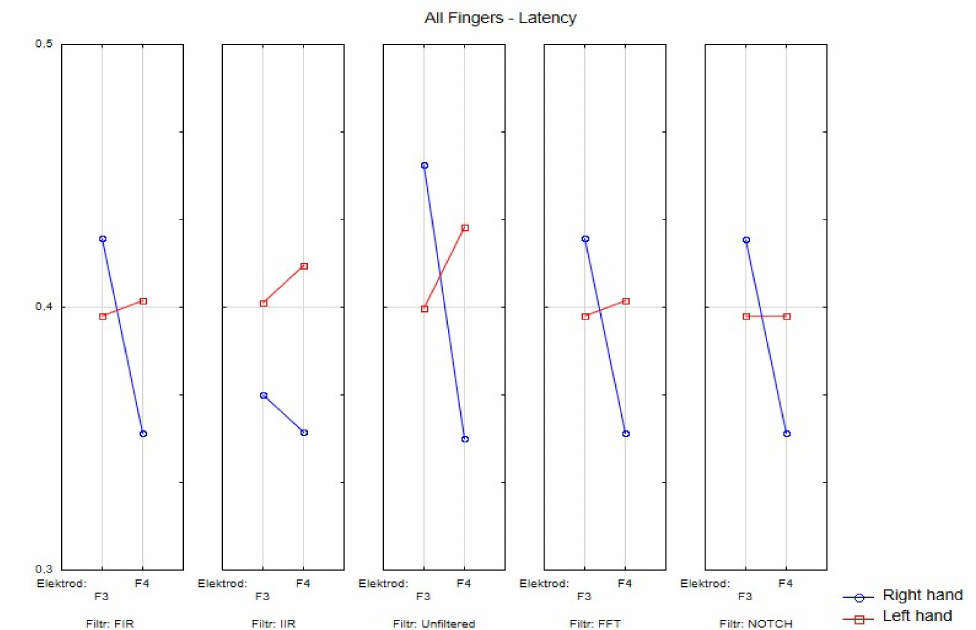
Figure 3. Presentation of the average latency values for the F3 and F4 electrodes for the right and left hands for selected filters. Comparisons of all selected filters were made. The graphs can be read twofold. Latency and amplitude values can be compared for each of the fingers, for the right and left hands for the selected electrodes. In addition, the values for the selected filters are presented. Consequently, (comparing the results for individual fingers) for the right hand, the largest scatter was noticed for finger 4. The difference between the filters used was negligible. For the left hand, the largest scatter was for finger 3. Interestingly, in this analysis there